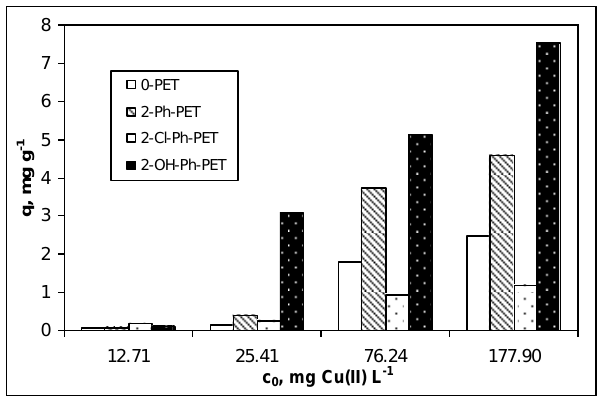
Figure 1. Adsorption capacities of functionalized PET waste at different initial Cu(II) ions concentration (pH = 6.5, contact time = 24 h, adsorbent dose = 8 g L −1 ).